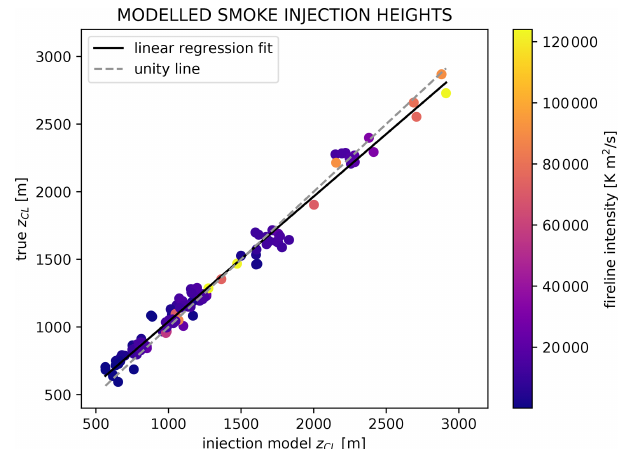
Figure 3. Comparison of true (as shown in Fig. 2) and modelled (from Eq. 8) smoke injection heights. Scatter points represent the 140 individual plume experiments within the LES dataset, with col- ors corresponding to fireline intensity I . The solid black line and dashed grey line denote the linear regression fit and unity line, re- spectively.